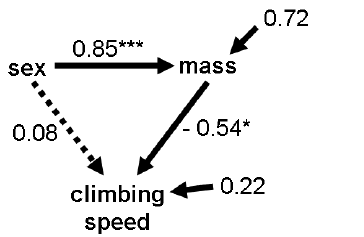
Fig. 3. Path analysis showing the direct and indirect relationship of spider sex with climbing speed. Numbers beside arrows that originate from variables indicate path coefficients. Numbers be- side arrows that point to variables, but are not originated from other variables, indicate error (unexplained) variances. The dot- ted arrow show the least parsimonious direct model (AICc = 26.6) and the continuous arrows the most parsimonious indirect model (AICc = 23.1), supporting the hypothesis that males climb faster than females because males are lighter. *, p = 0.05; ***, p <